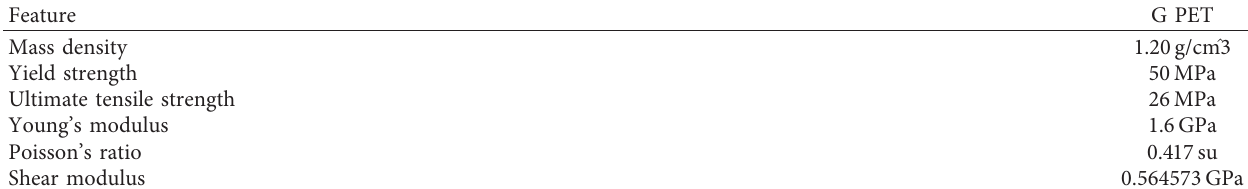
Table 2: Material properties used for FEM and RFM simulation.